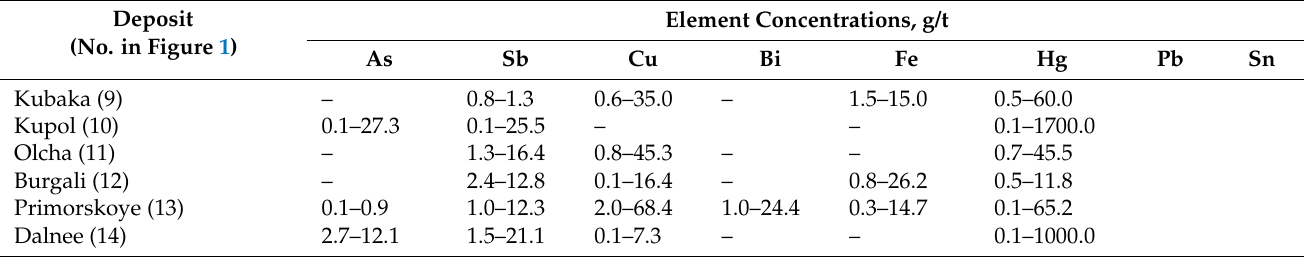
Table 4. Concentration of microimpurities in native gold from ores of gold–silver adularia GIT deposits.